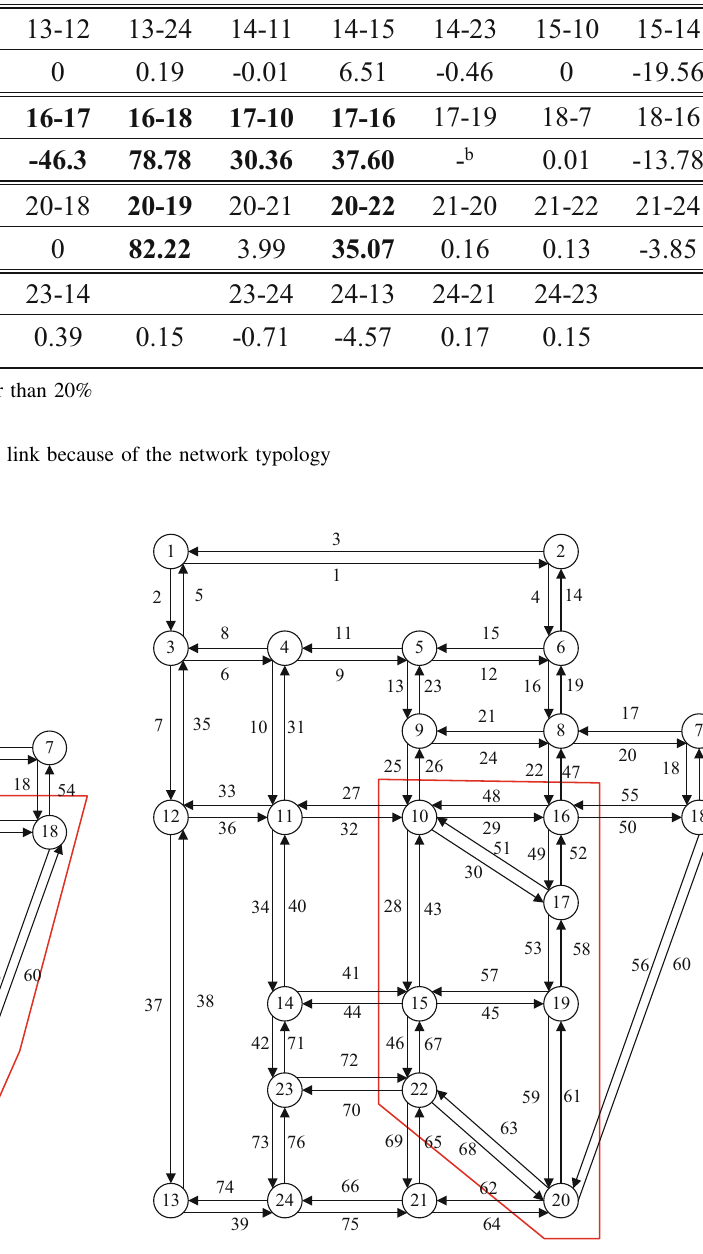
Fig. 10 Impact area identification by using the link flow change as the criterion